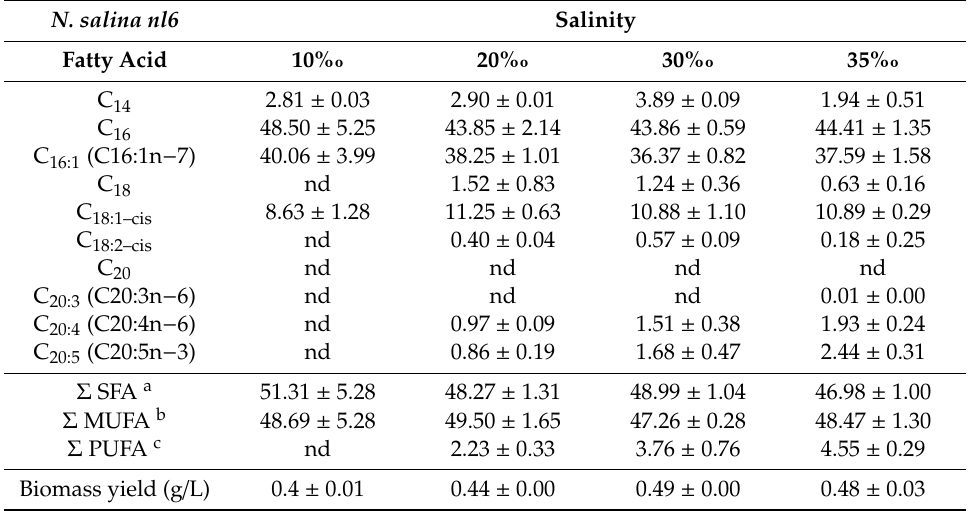
Table 4. Fatty acid profiles of N. salina nl6 in di ff erent salinities (n = 2) harvested in stationary phase. N. salina nl6